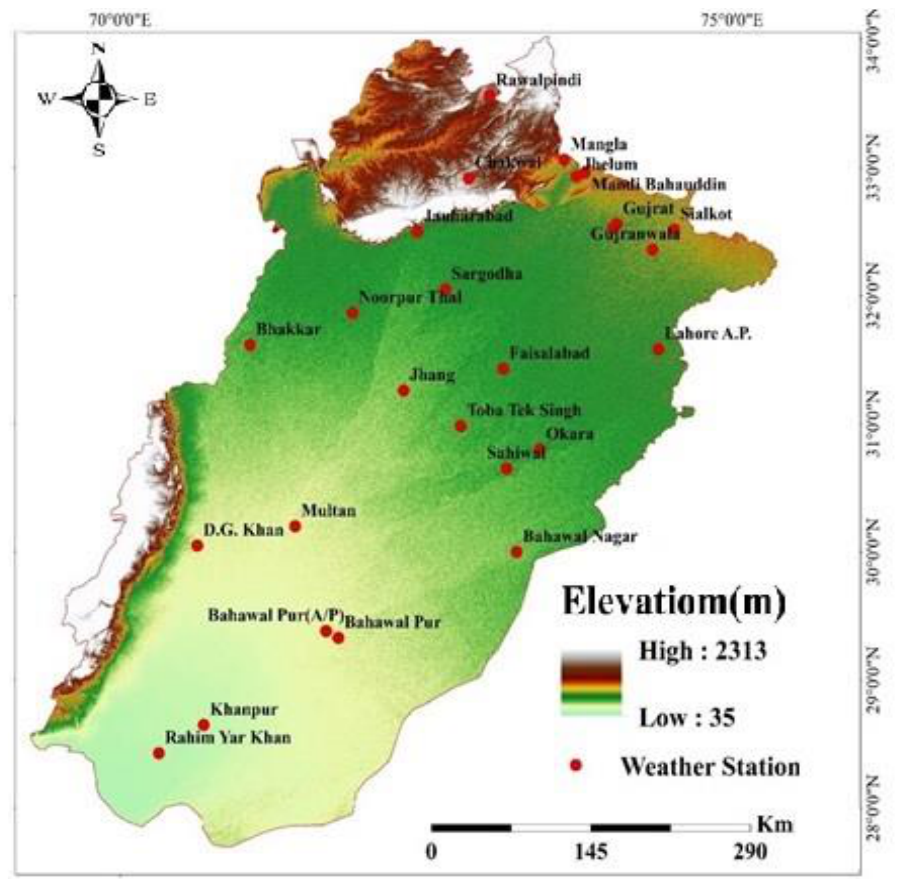
Figure 1. Topographic features of Punjab Province and locations of considered weather stations.